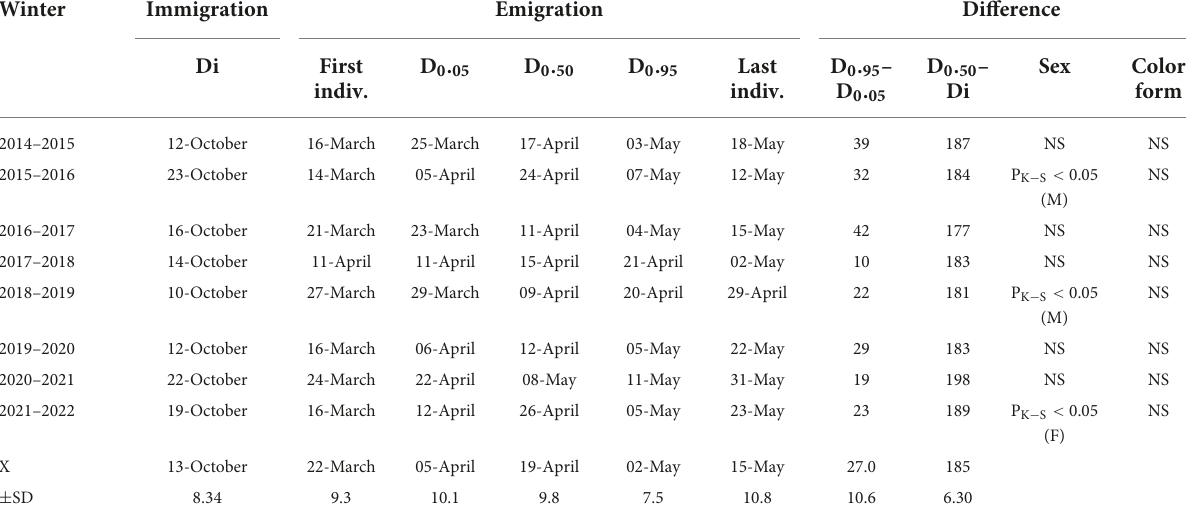
TABLE 1 Immigration and emigration of adults from artificial